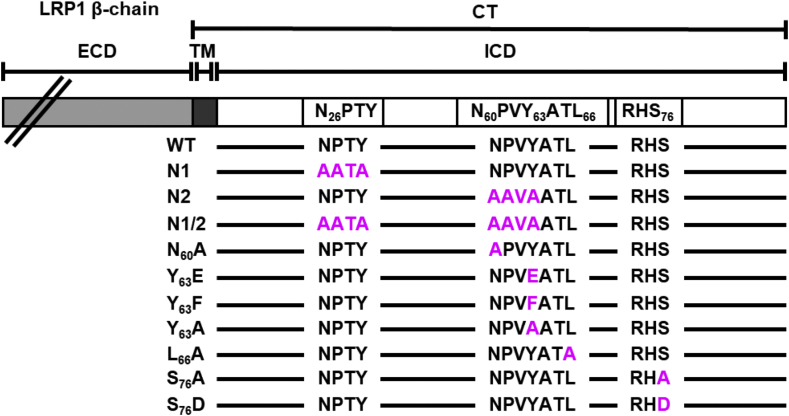
Domain structure and potential PID1 binding motifs of LRP1. The extracellular (ECD), as well as the transmembrane (TM) and intracellular (ICD) domains forming the carboxy-terminus (CT) are indicated. The proximal and distal NPxY motifs as well as the RHS motif of the ICD are indicated. Wild type (WT) and mutant LRP1-ICD lacking the functional proximal (N1), distal (N2) or both (N1/2) NPxY domains as well as amino acid substitutions within these domains created for biochemical binding analyses are highlighted in pink.